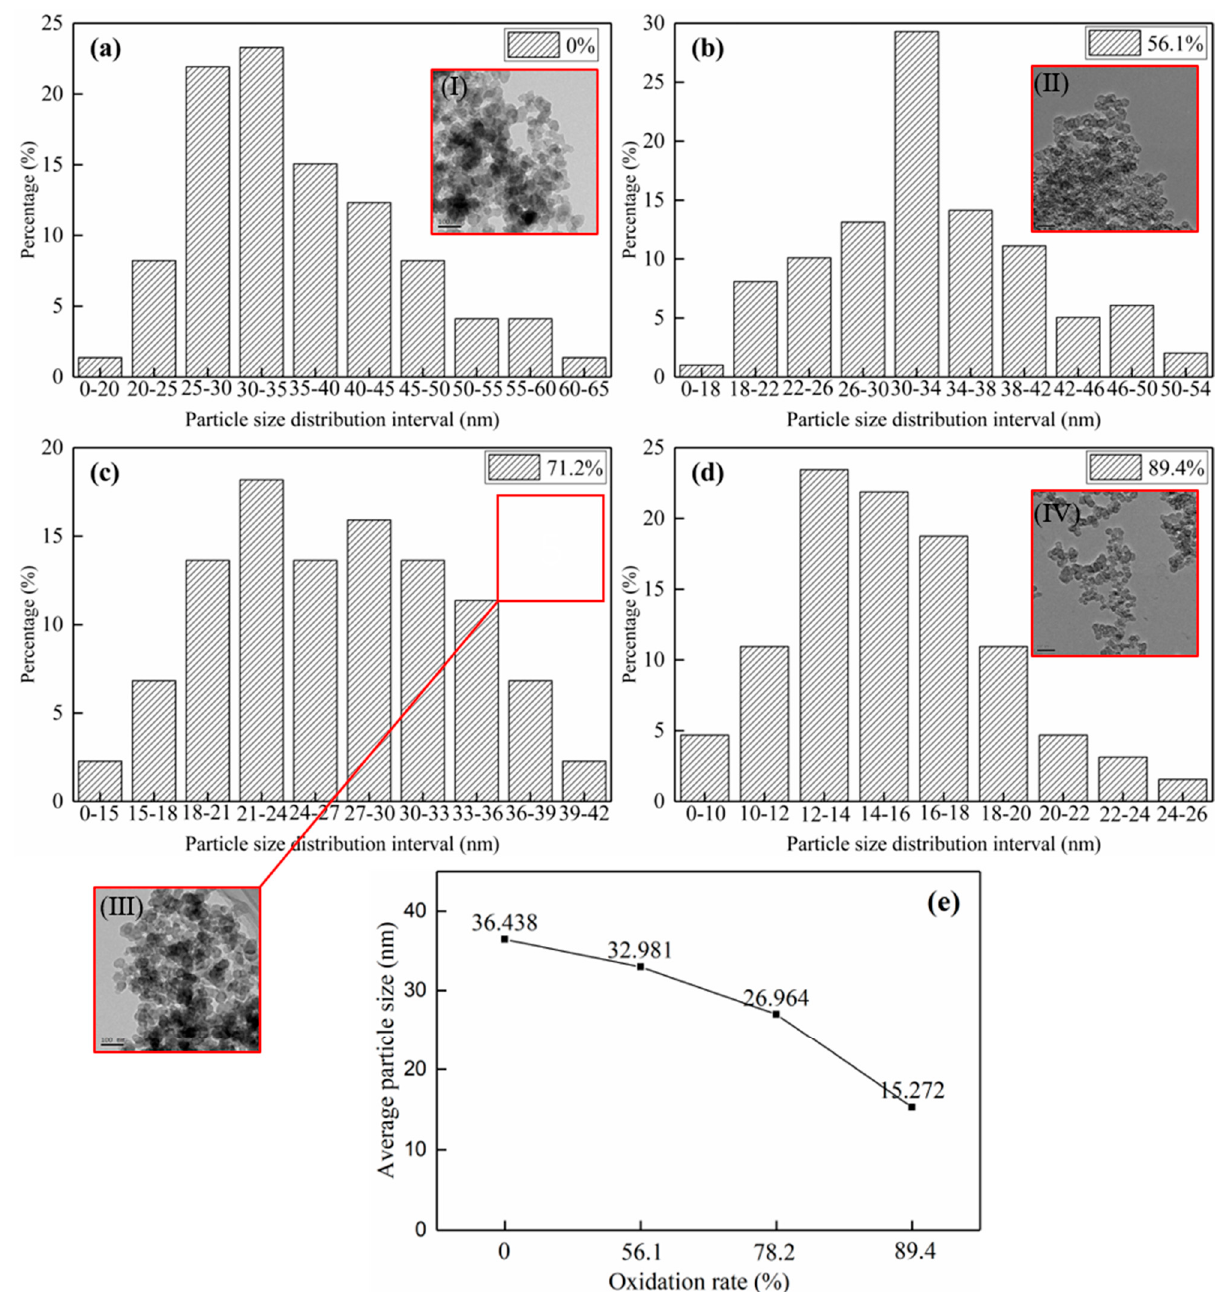
Figure 5. Particle size distribution and average particle size for different soot oxidation rates: ( a ) 0%, ( b ) 56.1%, ( c ) 71.2%, ( d ) 89.4%, ( e ) average particle size.